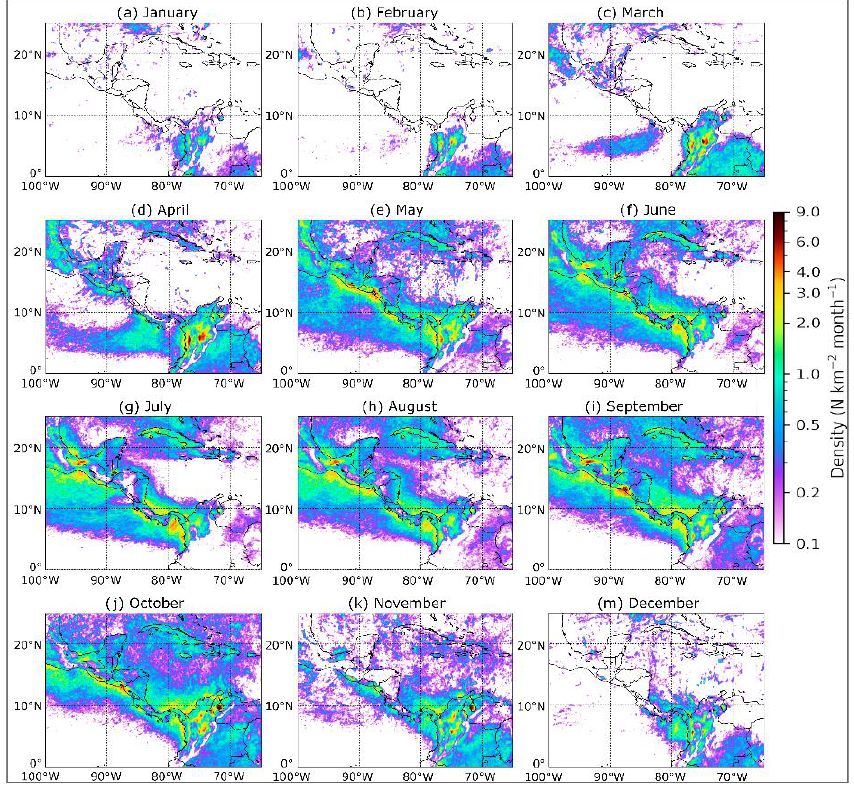
Figure 4. Average monthly lightning density (N km −2 month −1 ) over the ECA for 2012–2020. Data from the World Wide Lightning Location Network (WWLLN).